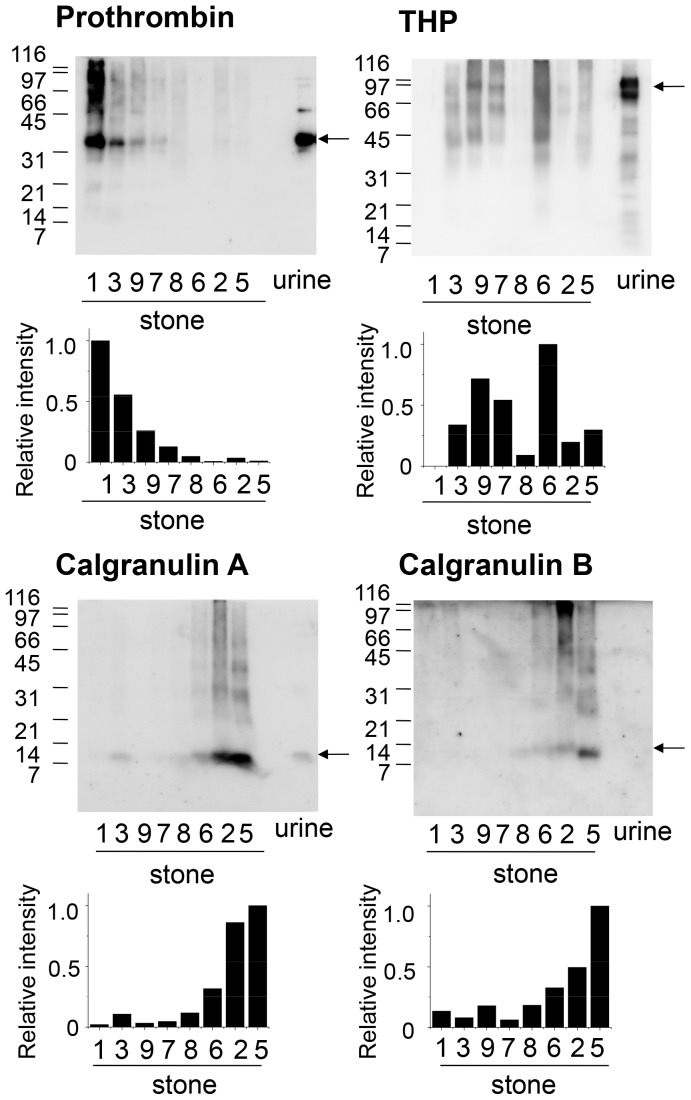
Western blot analysis of major proteins in CaOx kidney stones.Extracts of CaOx kidney stones containing 0.1 µg proteins were separated by SDS-PAGE and blotted on a PVDF membrane. To confirm the reactivity of antibodies and indicate the size of the proteins in urine, a concentrated urine sample from a normal subject (1 µg protein) was applied on the last lane of each gel. The membrane was then probed with anti-prothrombin fragment 1, anti-calgranulin A, anti-calgranulin B or anti-THP antibodies. Arrows indicate the positions of prothrombin fragment 1 (upper left), full length THP (upper right), full length calgranulin A (lower left), and full length calgranulin B (lower right). Western blotting was repeated two times and gave similar results. When Sample 1, 3, 9 and 7 (Group 1) was compared with Sample 8, 6, 2 and 5 (Group 2), p-value of Mann-Whitney U-test was 0.028 for prothrombin, calgranulin A and calgranulin B, while that for THP was 0.8857.